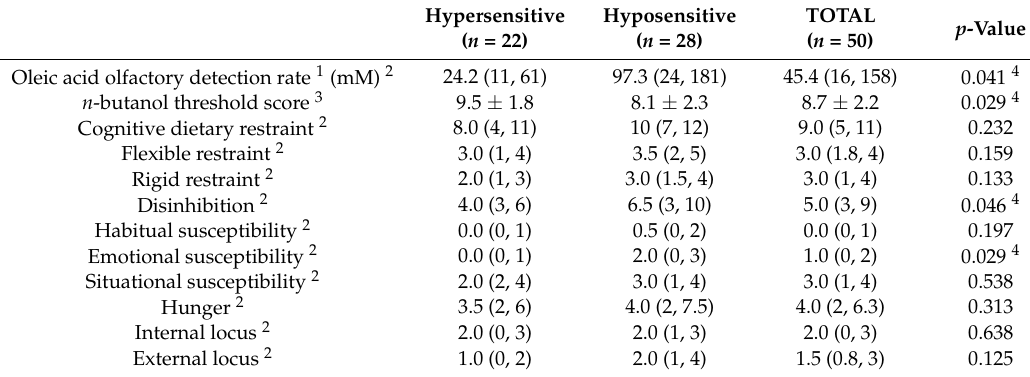
Table 4. Comparison of TFEQ scores and olfactory detection for hyper- and hyposensitive taste groups.